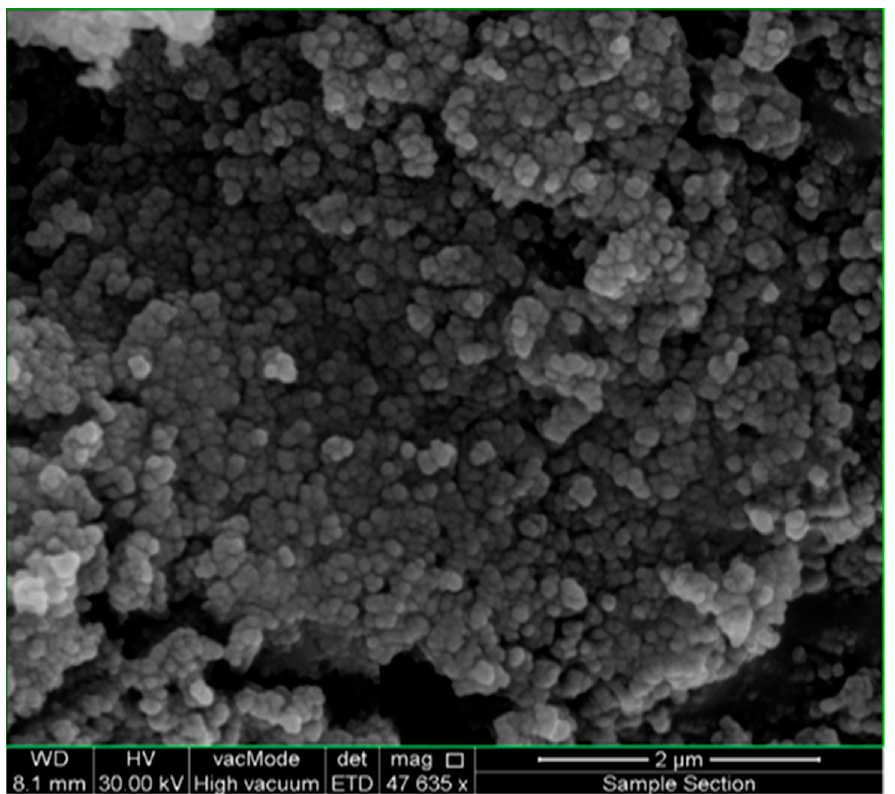
Figure 4. Shows the typical FE-SEM images of the AgNPs synthesized using aqueous sidr